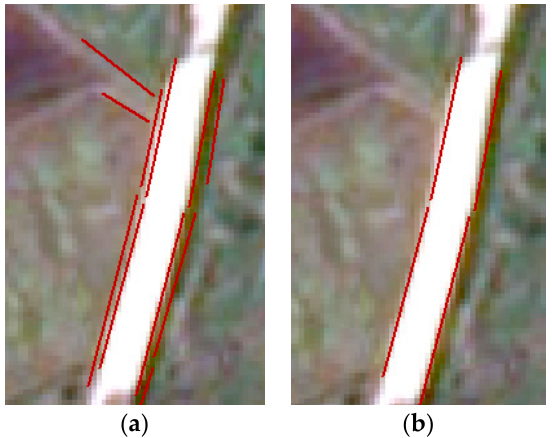
Figure 5. Candidate road segment detection: ( a ) detected straight lines; ( b ) candidate road segment.